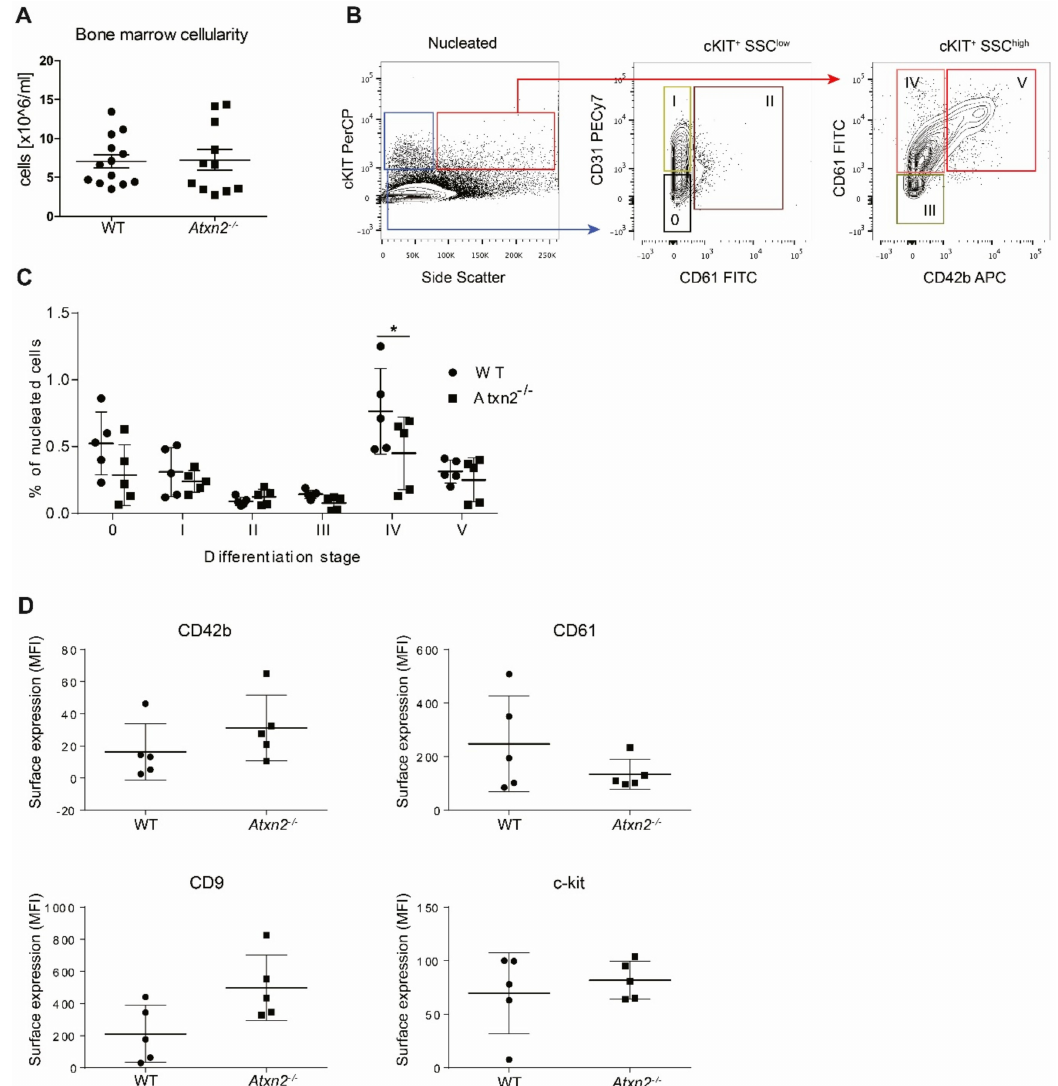
Figure 5. ATXN2 deficiency alters early megakaryocytic di ff erentiation. ( A ) Femurs of WT or Atxn2 − / −